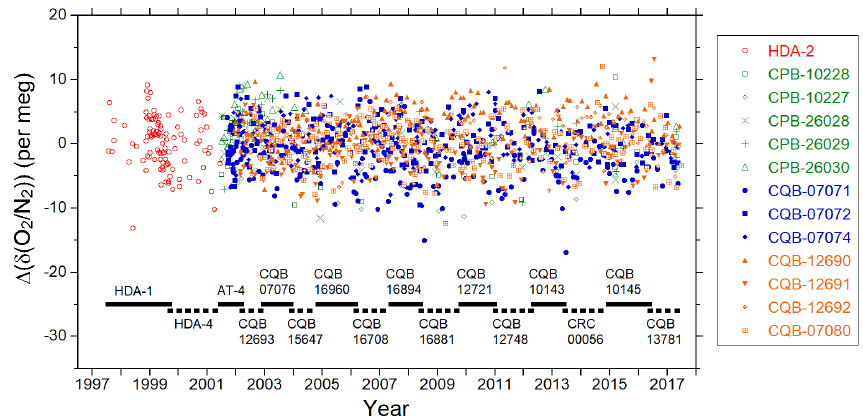
Figure 2. Temporal changes in the O 2 / N 2 ratio of primary reference gases relative to the NIES O 2 / N 2 scale. The differences of the O 2 / N 2 ratio from the average are plotted for HDA-2 along with the differences of the O 2 / N 2 ratio from the initial values for the individual cylinders except HDA-2. Solid and dashed horizontal bars in the lower part of the figure indicate the periods when the working reference gases were used.